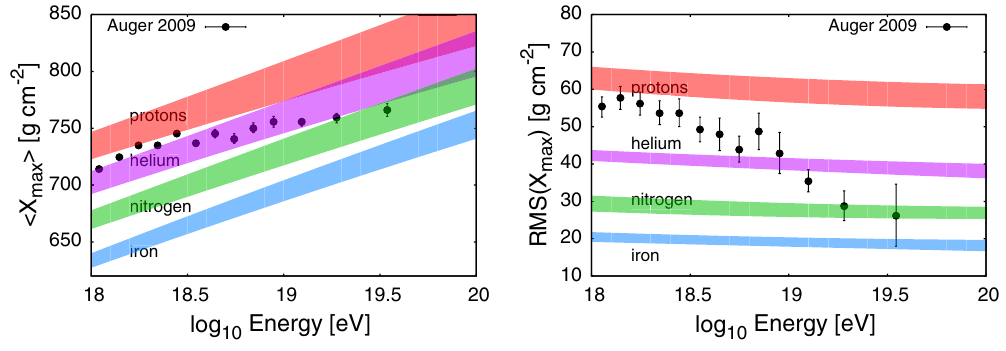
Figure 1. Plots showing PAO measurements of the composition sensitive quantities (cid:2) X max (cid:3) and RMS( X max